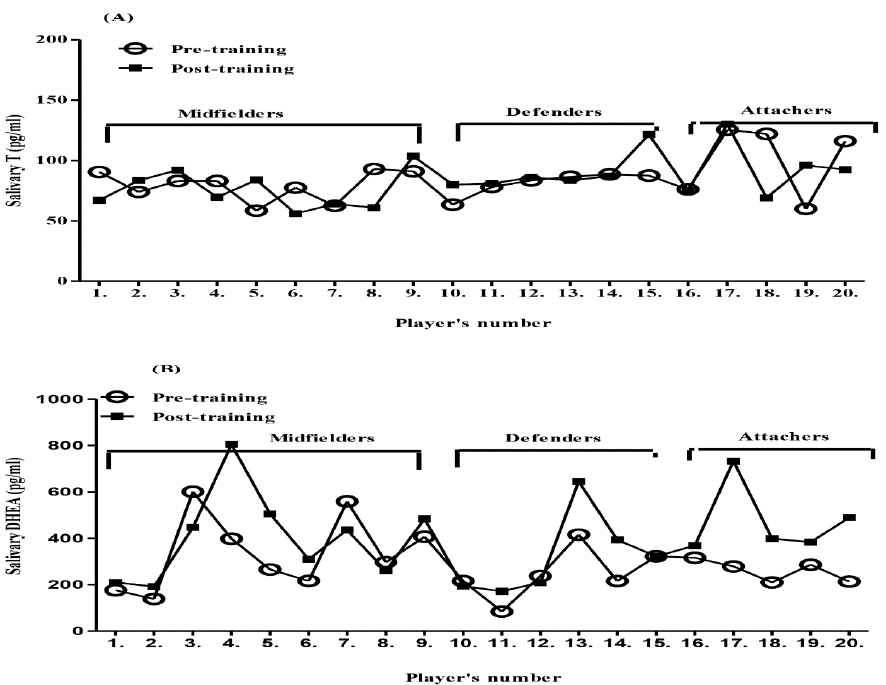
Figure 2. Pre- and post-exercise rhythms of ( A ) Sal-T levels and ( B ) Sal-DHEA levels in 20 young professional soccer players in three different positions.